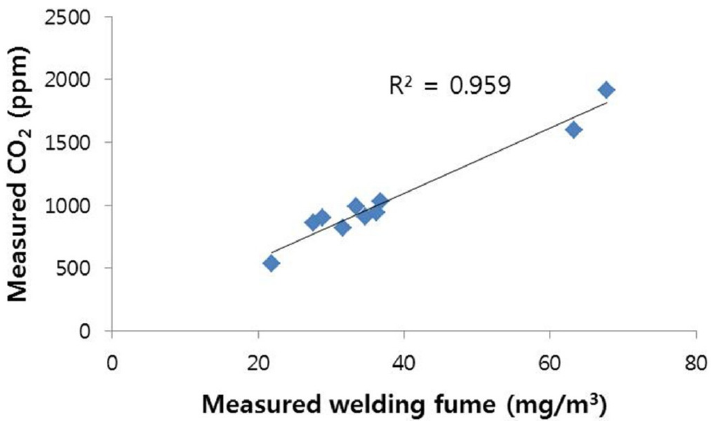
Figure 9. Correlation of measured welding fume and measured CO 2 .